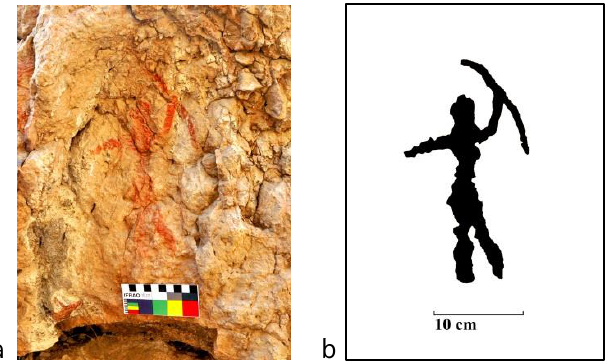
Figure 15. Site V. ( a ) Depiction of a human shape. ( b ) Drawing of the human form based on the photograph.